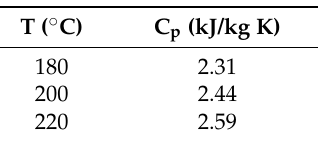
Specific heat capacity ( C p ) values for three temperatures of mesophase interval of